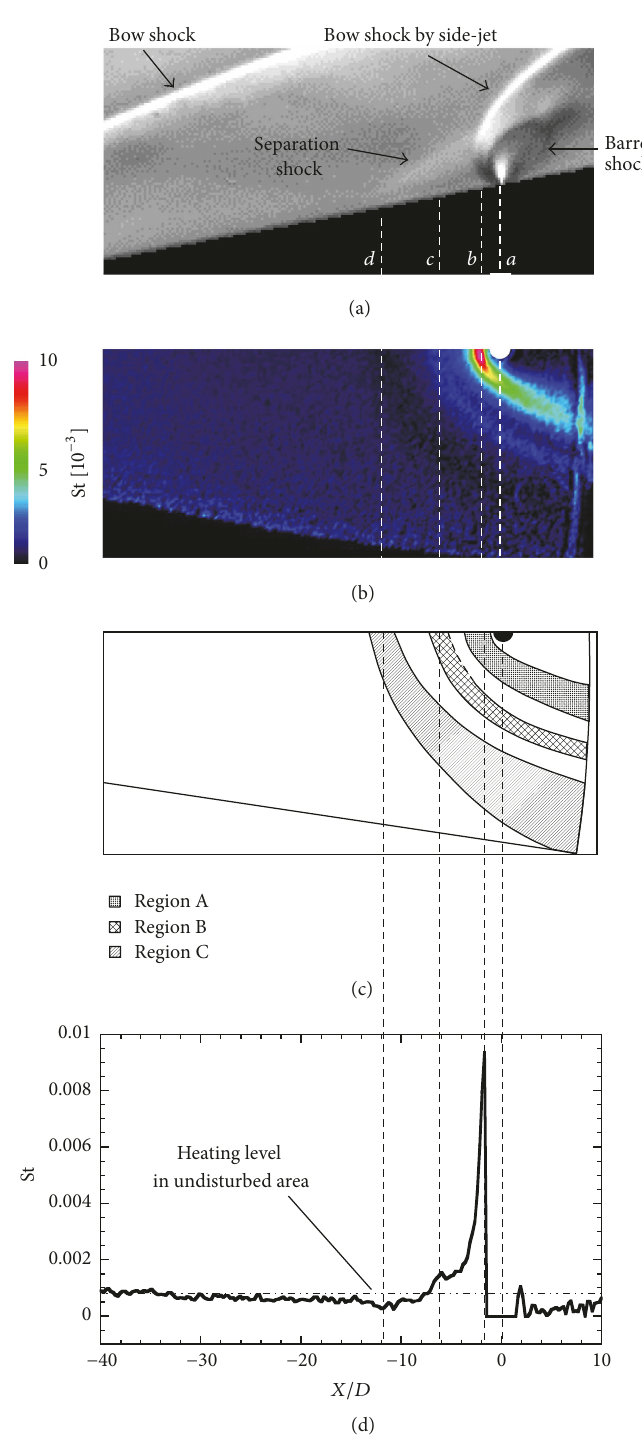
Figure 10: St distribution in the case of single-jet injection. (a) Schlieren photograph with single injection at SJ1. (Point a : locus of injection hole, point b : locus with peak Stanton number, point c : peak by separation vortex, and point d : separation point.) (b) Surface distribution of St measured by TSP. (c) A schematic of the heating patterns and (d) a one-dimensional profile of St on the 𝑥